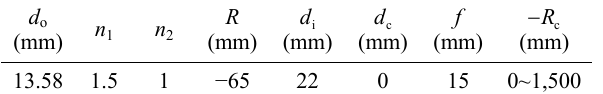
Fig. 7 d a1 and d a2 vary with the radius of cylindrical lens. Table 2 Structure parameters used in Fig.